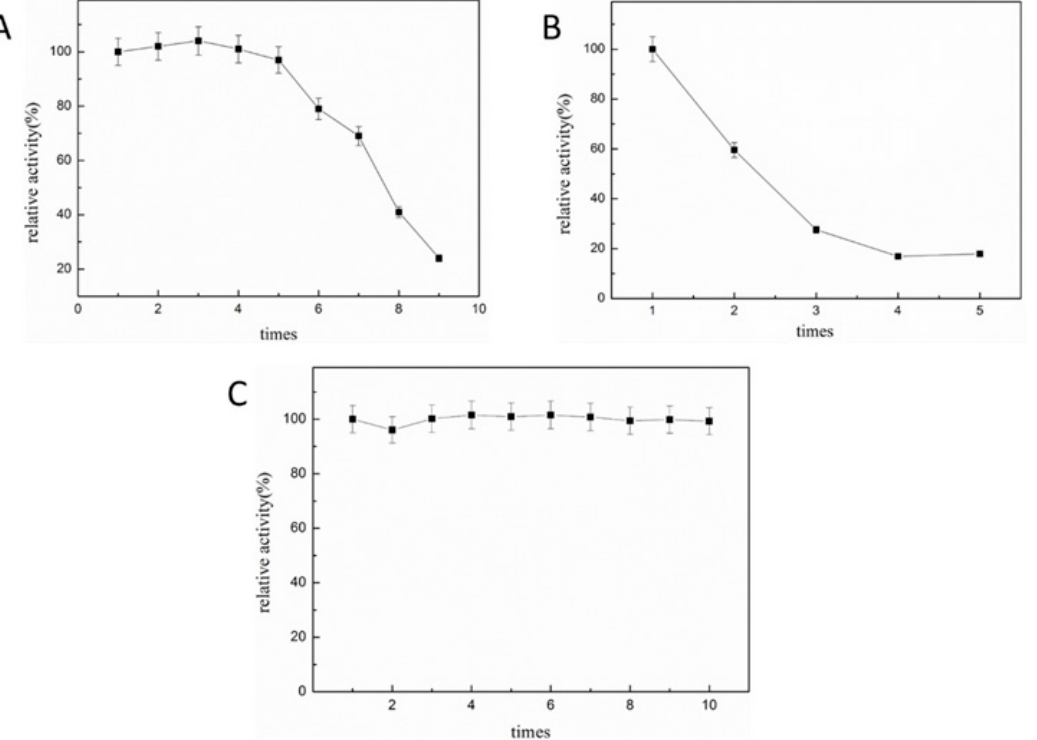
Figure 5. The effect of reuse on immobilized enzymes in reactors. The activity of site-specific covalently-immobilized enzymes in a batch reactor ( A ); the activity of enzyme immobilized by physical adsorption in a batch reactors ( B ); and the activity of site-specific covalently-immobilized enzymes in a semi-continuous flow reactor ( C ). The tests were carried out at room temperature.